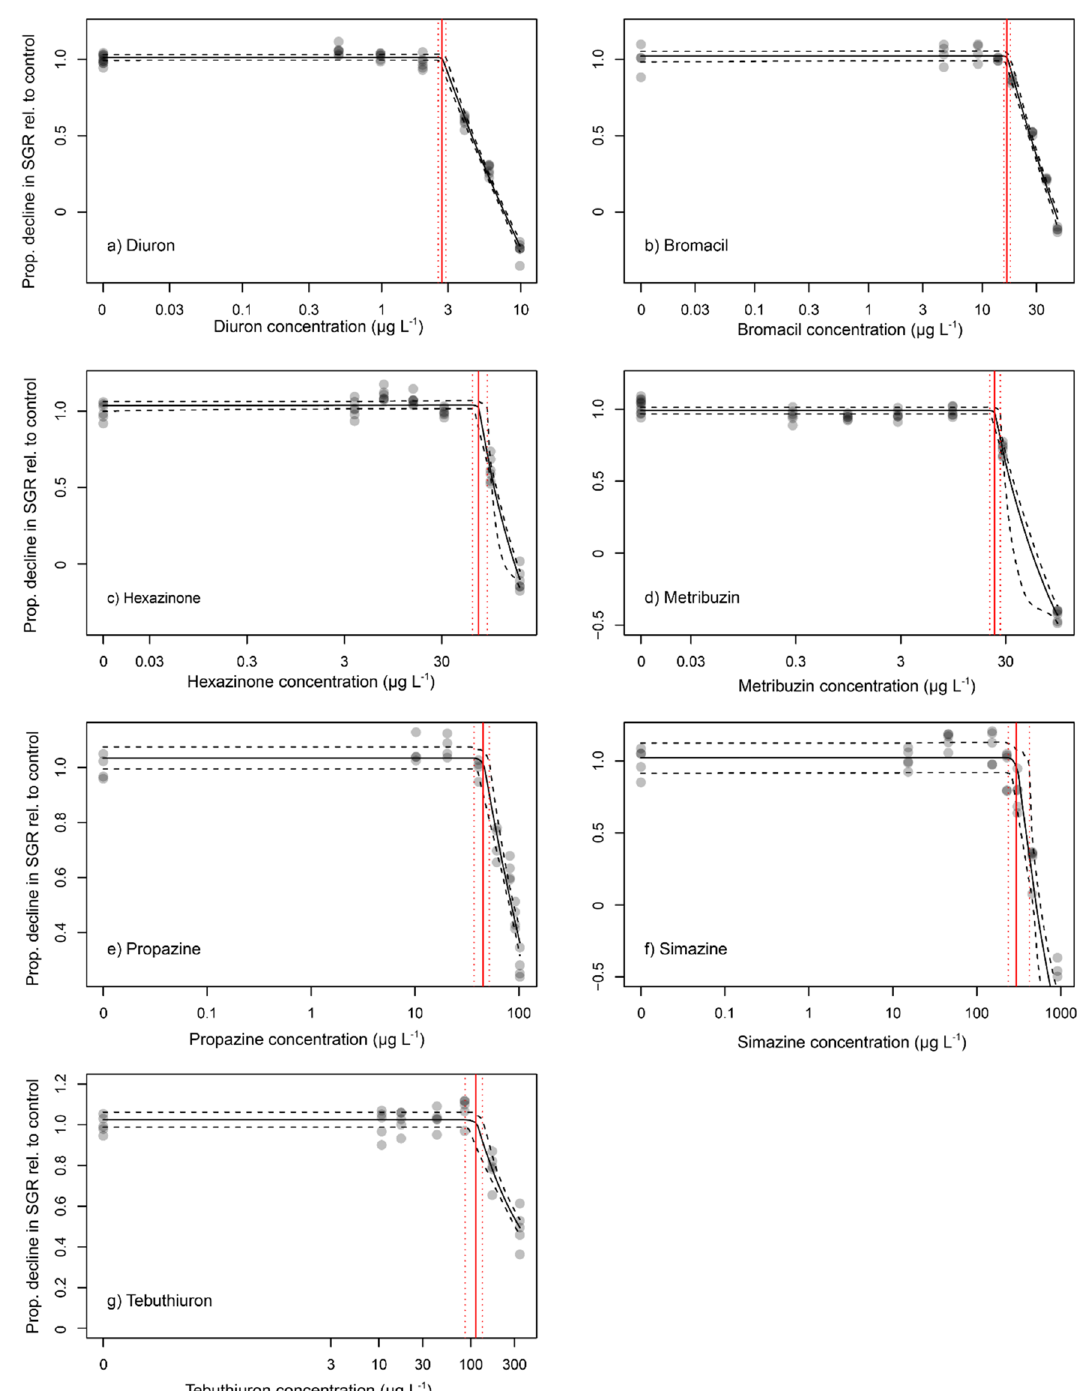
Figure 2. Proportional decline of specific growth rate (SGR) for Cladocopium goreaui relative to control treatment (solid black line) and 95% confidence intervals (black dashed line) to derive no effect concentration (NEC) (red line) and 95% confidence interval (red dashed line) of ( a ) diuron; ( b ) bromacil; ( c ) hexazinone; ( d ) metribuzin; ( e ) propazine; ( f ) simazine; and ( g ) tebuthiuron from Bayesian non-linear gaussian model fits. All concentrations in µg L −1 (n = 4–6 per